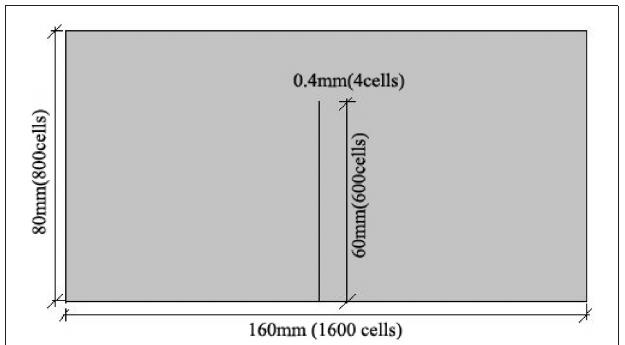
FIGURE 5 | Schematic diagram of the cracking concrete model.